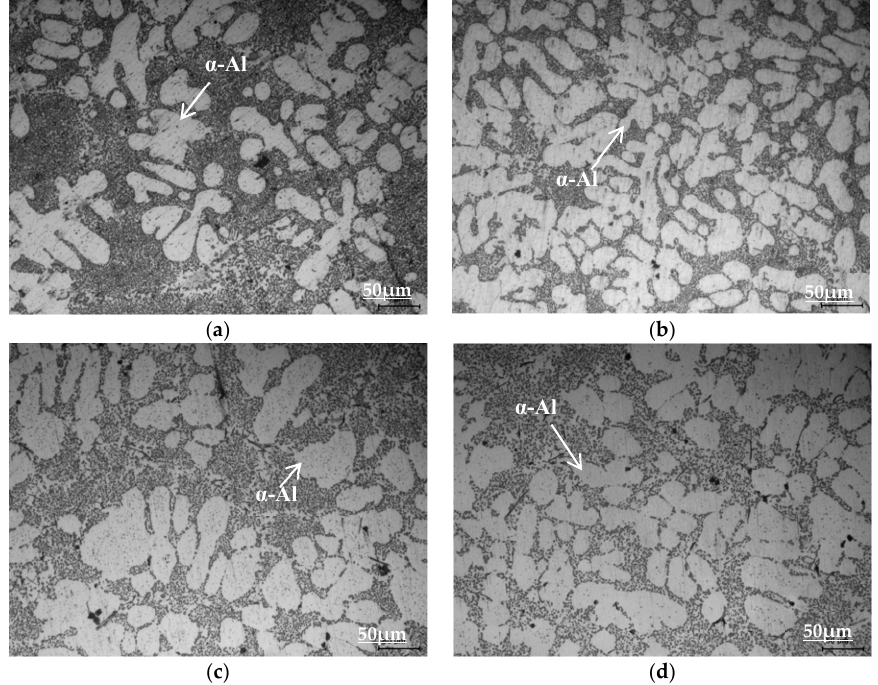
Figure 6. Effect of alloying elements on the OM microstructure of Al-Si alloys: ( a ) Al-10Si-0.3Mg; ( b ) Al-10Si-0.3Mg-0.2Er; ( c ) Al-10Si-3Cu-0.3Mg; ( d ) Al-10Si-3Cu-0.3Mg-0.2Er. Table 2. Effect of alloying elements on secondary dendrite arm spacing (SDAS) in Al-Si alloys with different composition.